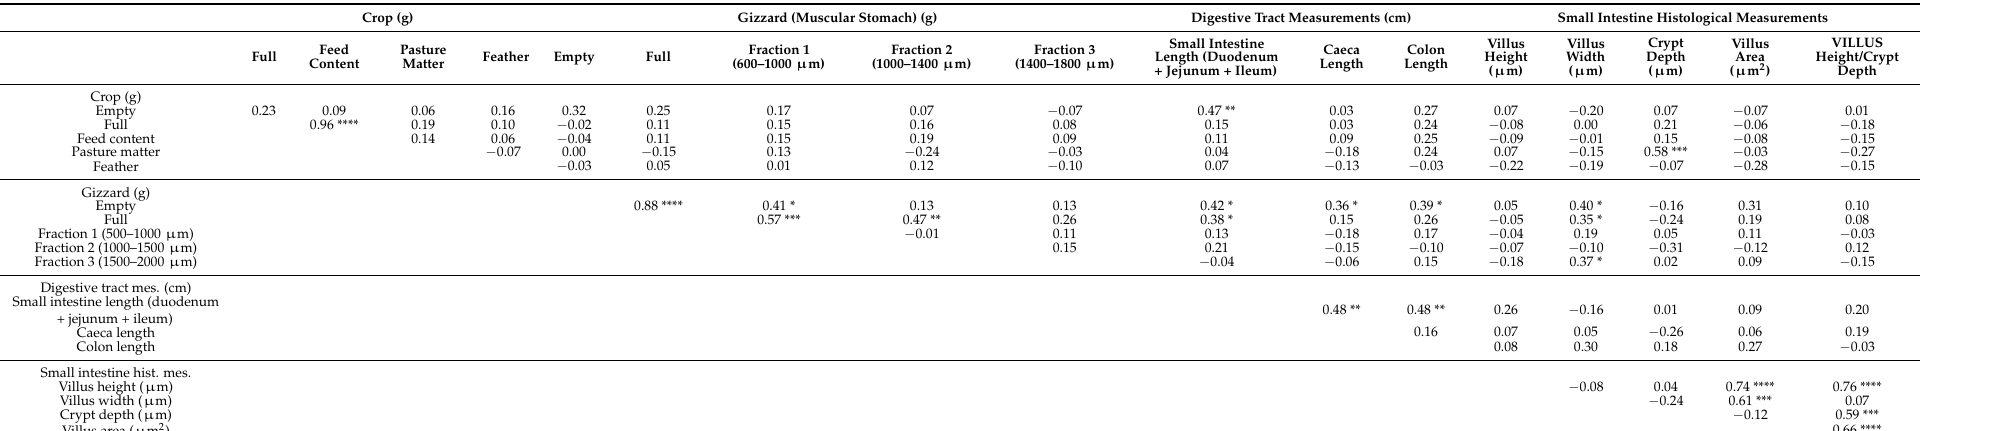
Table 3. Spearman correlations between gastrointestinal tract morphometrics and content of green-legged partridge chickens.